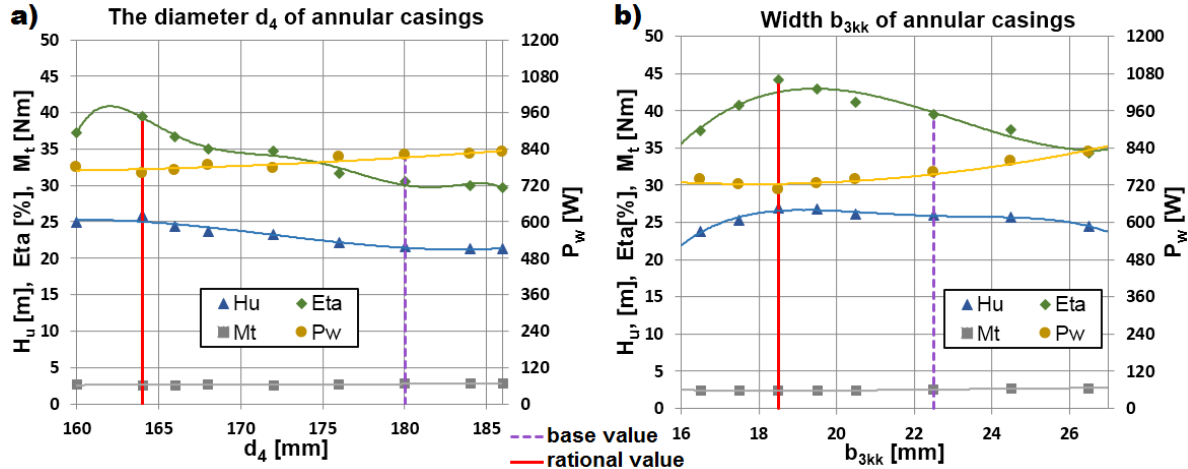
Figure 8: Influence of changes of the diameter d 4 (a) and width b 3 kk (b) of the annular casing.